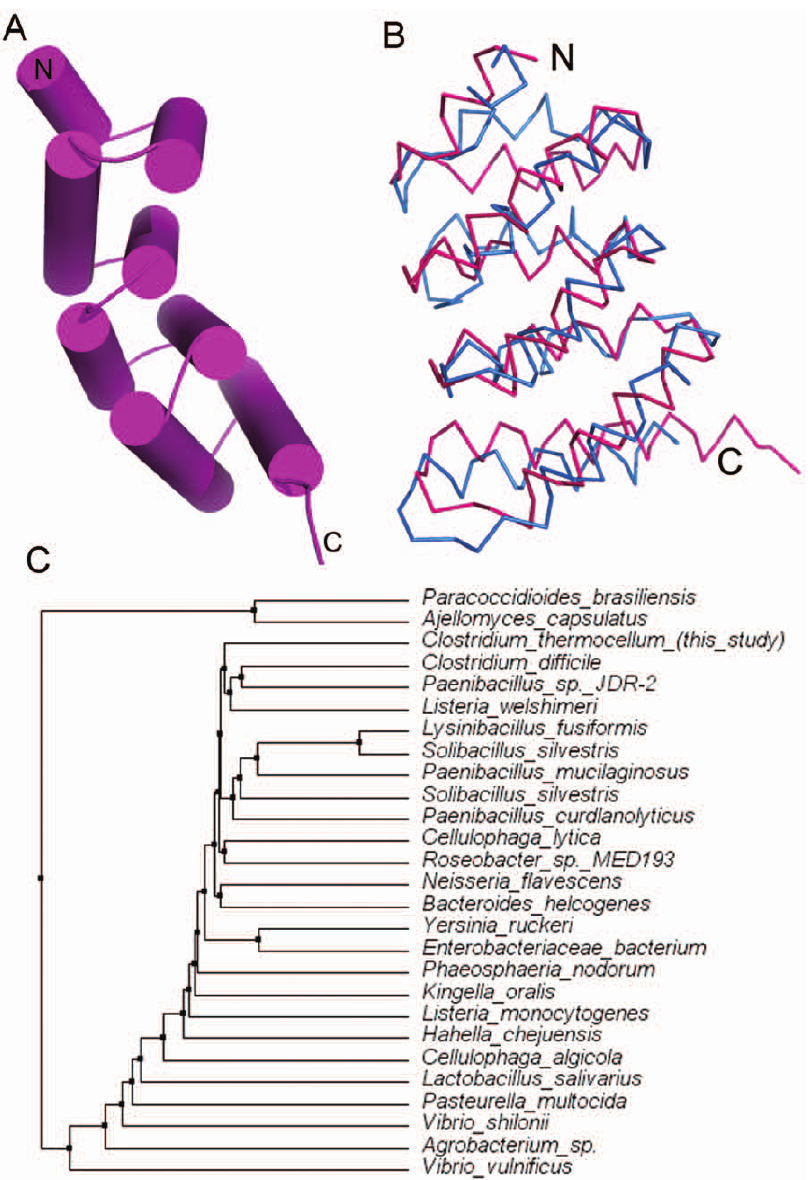
Figure 6. Modelling of Cthe_2751. (A) Cartoon of the model predicted by I-TASSER (B) Superposition of the C a atoms of the predicted structure (magenta) over the experimental crystal structure (blue). (C) Average distance tree for Cthe_2751 constructed by the Jalview 2.6.1 Java alignment editor using BLOSUM62.